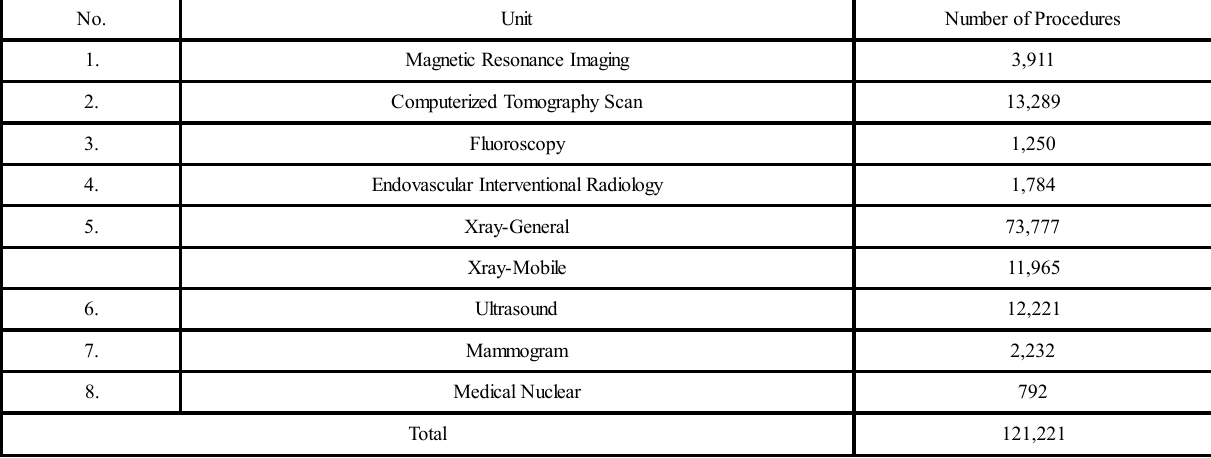
TABLE 1..TOTAL NUMBER OF PROCEDURES PERFORMED IN PATIENTS BY UNIT IN 2011